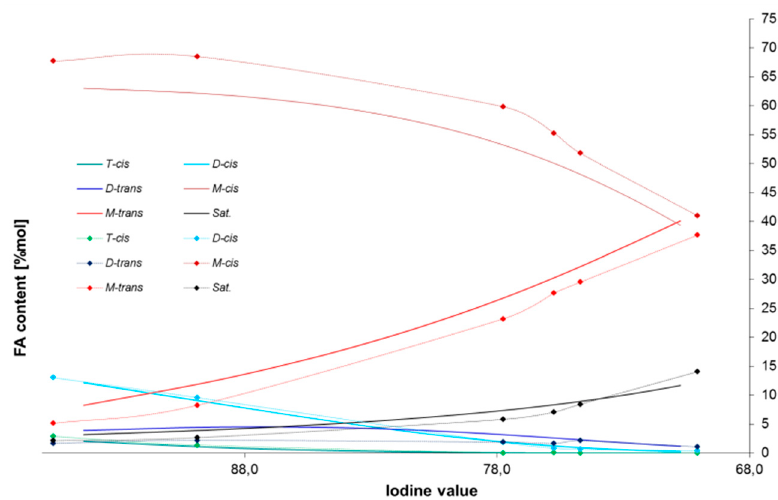
Figure 4. Predicted (solid line) and experimental (dotted line) fatty acids contents of canola oil hydrogenated with INS Ni_C catalyst. Reaction conditions: temperature 180 °C, H 2 pressure = 1.5 bar(a), agitation 950 rpm.